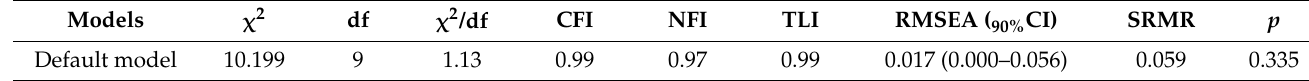
Table 6. Goodness-of-fit indices of the confirmatory factor model.